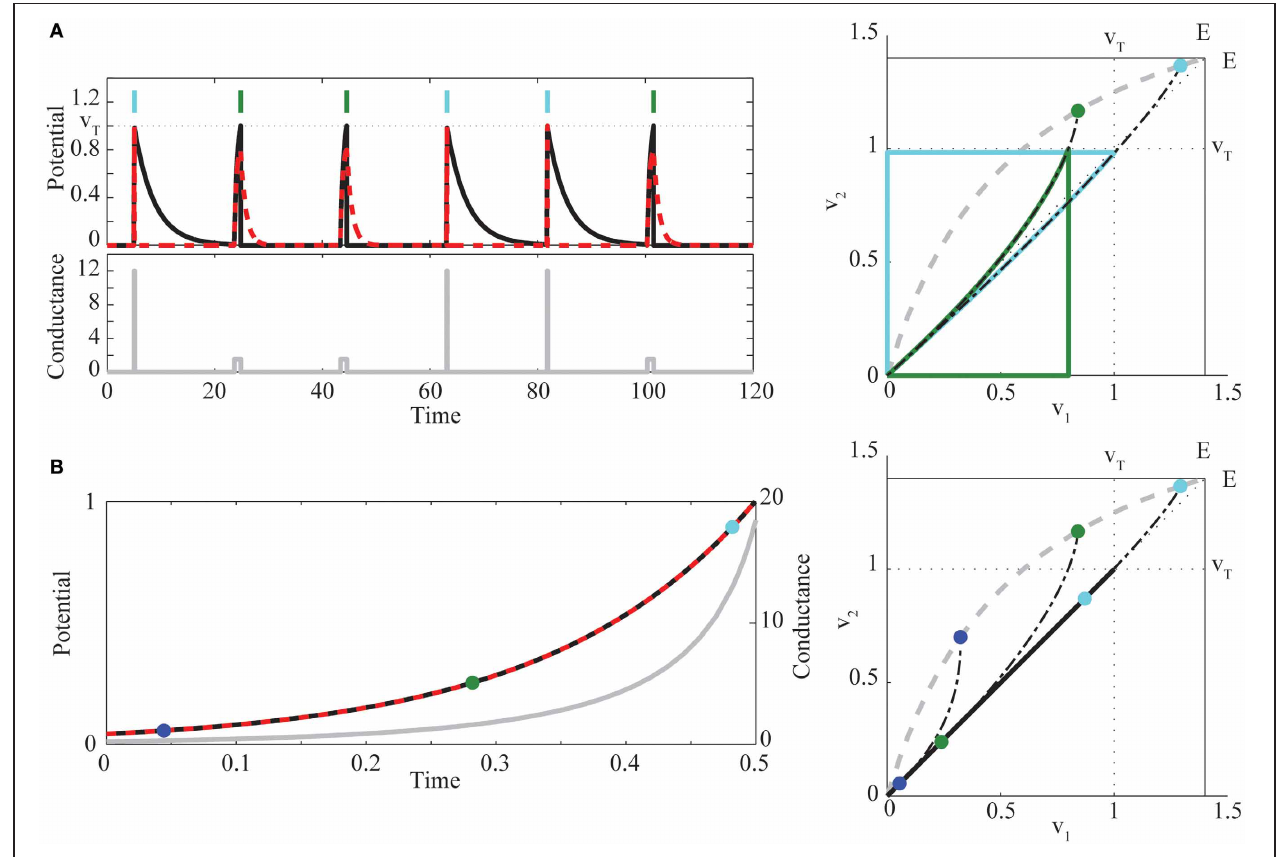
FIGURE 2 | (A) ( left ) Example of bimodal pulse control in two neurons, for the target sequence ( 1 , 2 , 2 , 1 , 1 , 2 ) , indicated by light blue (neuron 1) and green (neuron 2) vertical bars [ red dashed , v 1 ( t ) , black , v 2 ( t ) , gray , g ( t ) ]. ( right ) Quasi-static phase plane illustrating bimodal control trajectories. For each fixed value of g , there exists a unique stable fixed point V eq lying on a curve ( dashed gray ) running from ( 0 , 0 ) to ( E , E ) . The two chosen values of conductance g k determine if the solution starting at the origin first hits the threshold for neuron 1 ( light blue trajectory, g 1 = 12) or neuron 2 ( green trajectory, g 2 = 1 . 5). Trajectories